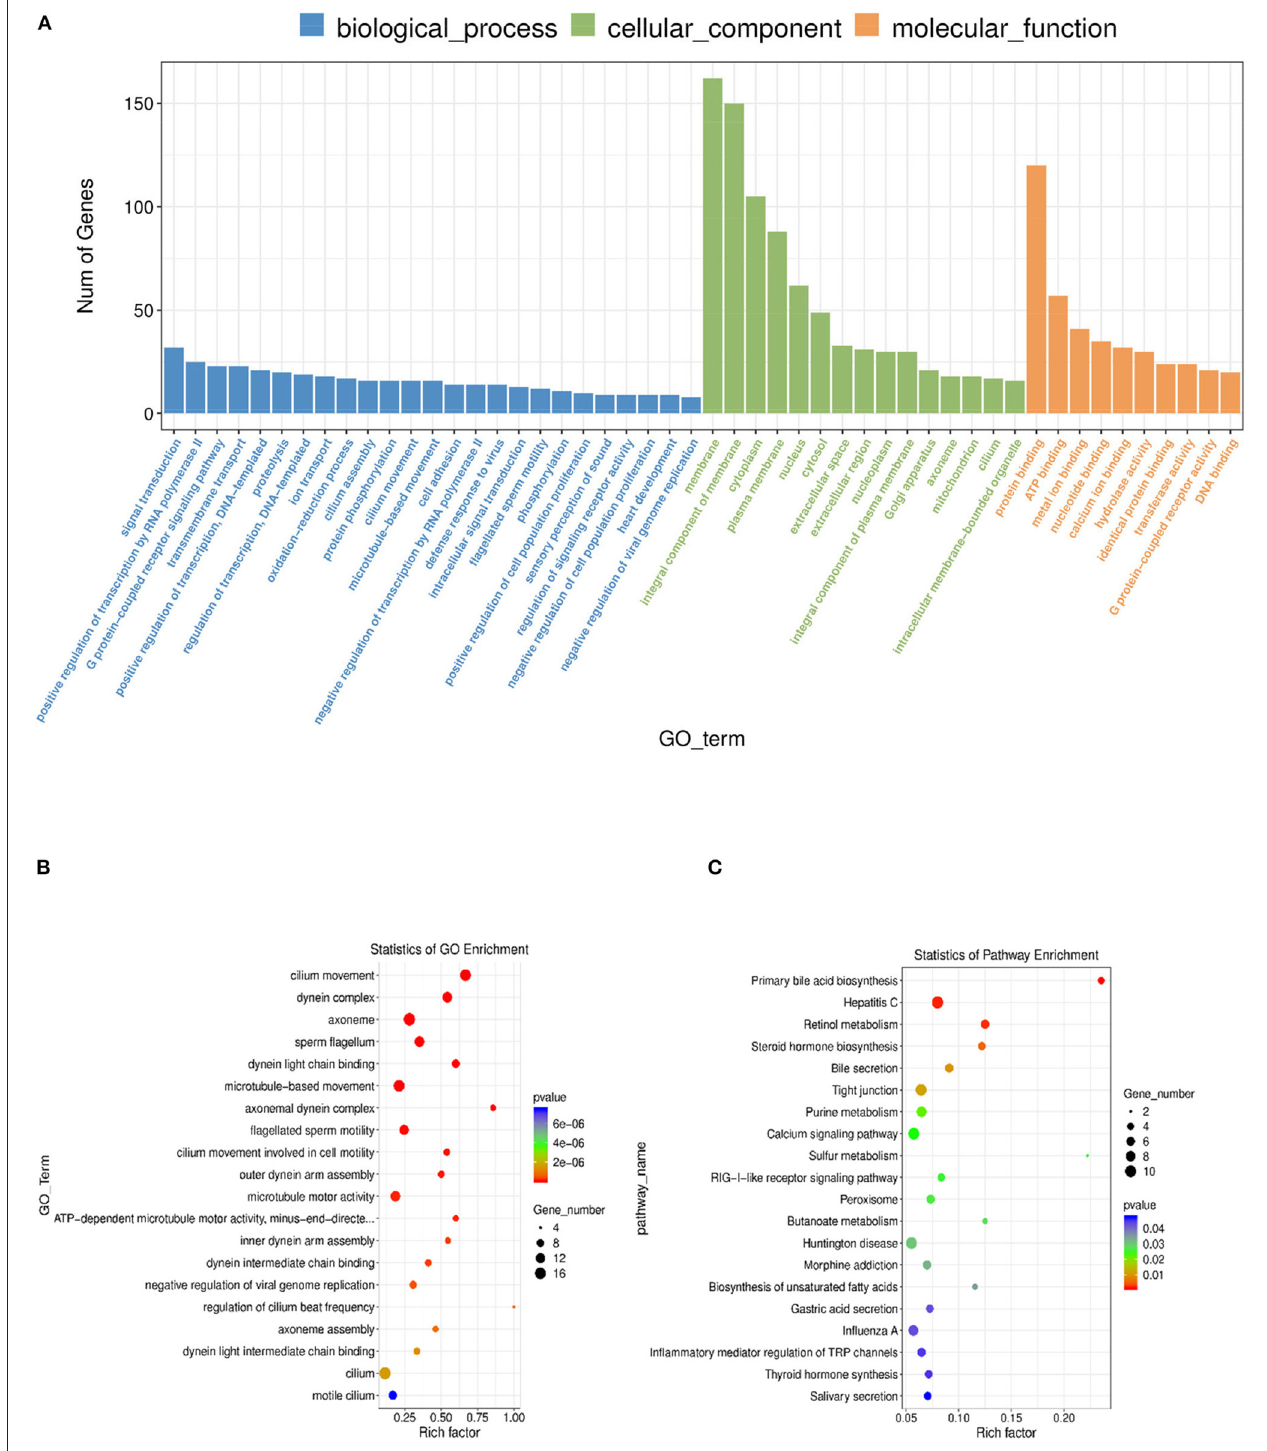
FIGURE 5 | GO and KEGG analysis of differential mRNA expression. (A) Histogram of GO enrichment of DE mRNAs. (B) Scatter plot of GO enrichment for DE mRNAs. (C) Scatter plot of KEGG enrichment for DE mRNAs.